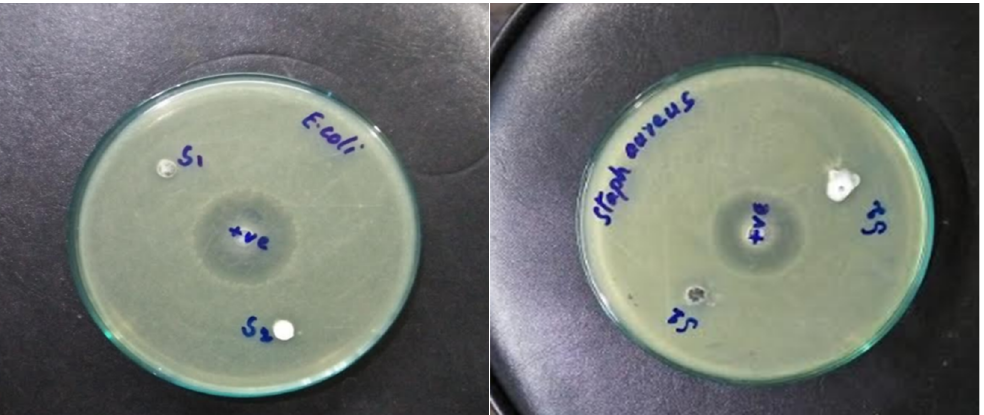
Figure 9. Photographic view of inhibition zones of P1 ( left ) and P2 ( right ) samples against E. coli and S. aureus bacteria. Table 2. Inhibition zones of samples P1 and P2 against E. coli and S. aureus bacteria .